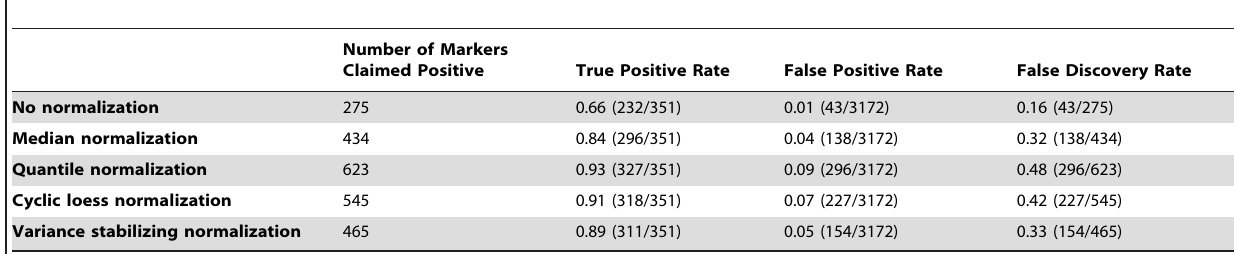
Table 2. Results of differential expression analysis of the test data before and after a combination of ComBat and normalization, in comparison with the benchmark